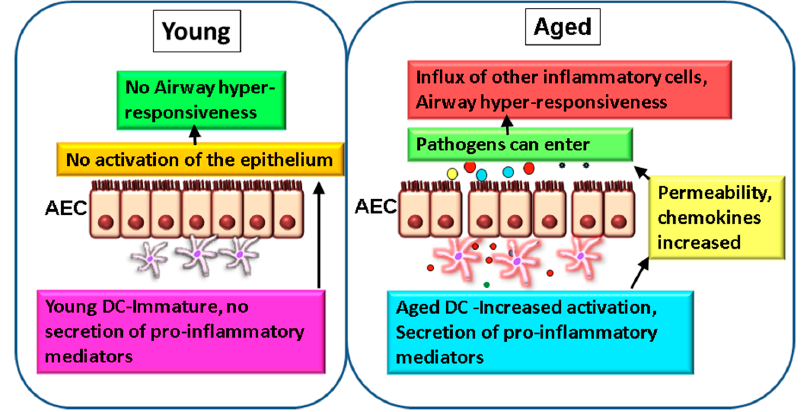
Figure 1. Altered DC-airway epithelial cell (AECs) crosstalk leads to impaired mucosal tolerance and inflammation in the elderly. In normal healthy lung from young subjects, dendritic cells (DCs) do not activate the epithelium at homeostasis and there is no inflammation and hyper-responsiveness ( left ). In contrast, in the aged lung, DCs secrete low levels of chronic inflammatory mediators, such as TNF- α and IL-6, which modulate the functions of AECs. The permeability, as well as secretion of chemokines (colored circles) by epithelium, are increased which allows infiltration of cells to the airways and leads to airway hyper-responsiveness. Permeability to infections is also increased ( right ). 6. Age-Associated Alterations in the Crosstalk between Airway Epithelial Cells and Dendritic